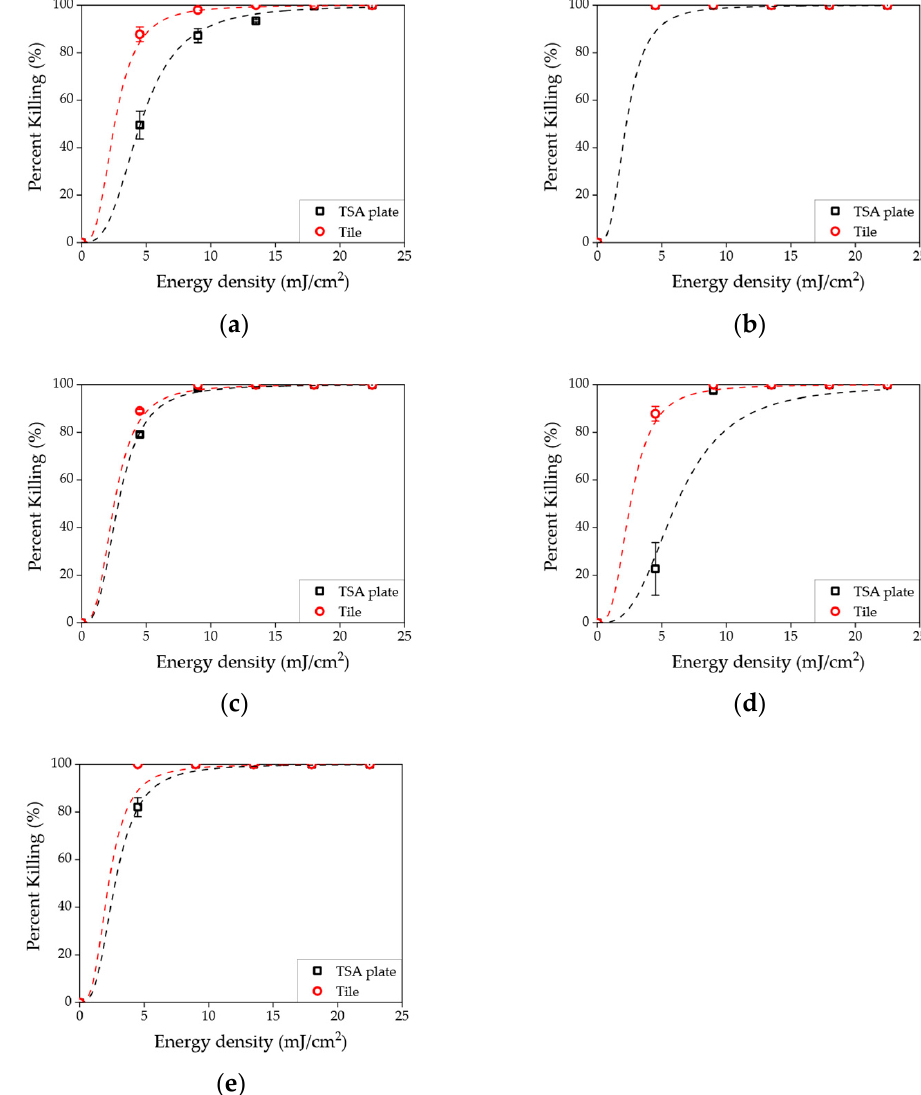
Figure 6. Percentage of killing rate as a function of energy density in nutrient-rich agar media (black rectangle) and solid surface (red circle) for ( a ) E. coli , ( b ) K. pneumoniae , ( c ) S. enteritidis , ( d ) L. innocua , and ( e ) S. aureus .